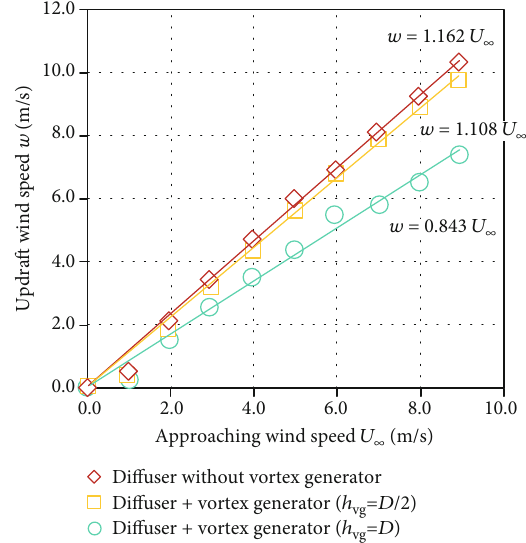
Figure 6: Updraft wind speeds in the case of the di ff user-shaped tower (experimental